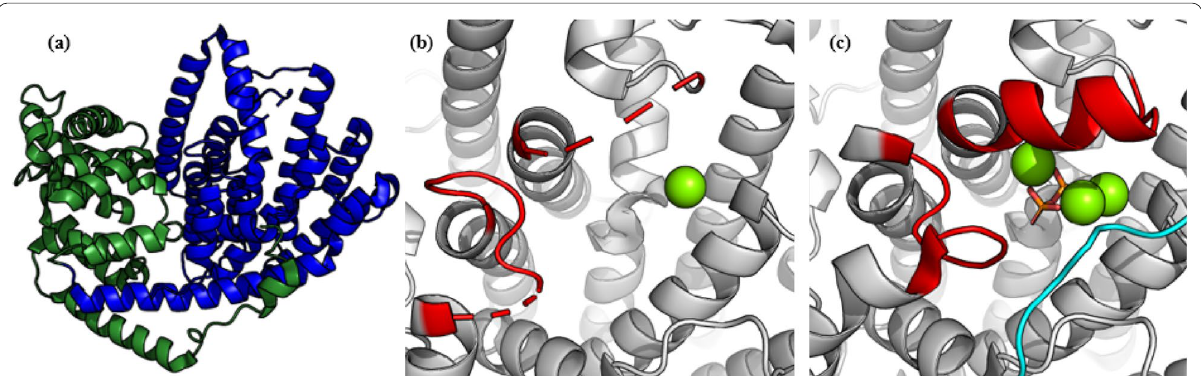
Fig. 6 Structure of bornyl diphosphate synthase. a Stereoplot of unliganded ( )‑bornyl diphosphate synthase (PDB ID: 1N1B ), looking into the + active site in the α domain (blue). Disordered polypeptide segments are indicated by dashed lines and the β domain is in green. b Active site of unliganded ( )‑bornyl diphosphate synthase. c Active site of the ( )‑bornyl diphosphate synthase complexed with inorganic pyrophosphate + + and Mg 2 + (green ball) (PDB ID: 1N1Z ). These conformational differences between unliganded enzyme and liganded enzyme mainly include the N‑terminal segment (cyan) and some loops (red) which help ‘close’ the active